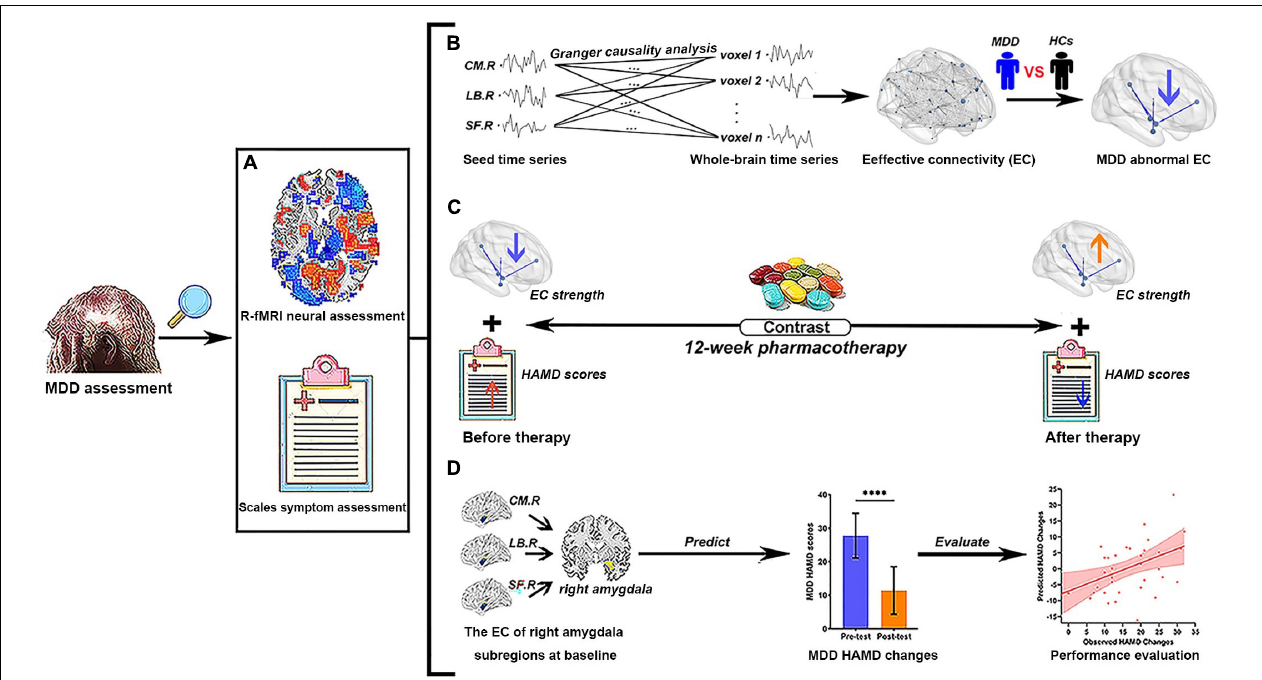
FIGURE 1 | Study flowchart of current research. (A) Two different MDD assessment methods were used in the present study. (B) The EC analysis of right amygdala subregions using Granger causality analysis. We explore abnormal right amygdala subregion-based EC in MDD patients by the comparison of R-fMRI data between MDD and HCs. (C) The contrast of the variance of EC strength and the changes of HAMD scores of MDD patients before and after pharmacotherapy, respectively. (D) The voxel-wise EC strength of right amygdala subregions at baseline is taken as feature sets to predict the changes of HAMD scores in MDD patients. The Spearman’s rank correlation between predicted HAMD scores changes and observed HAMD scores changes is used to evaluate the prediction power of current predictors. MDD, major depressive disorder; HC, healthy controls; R-fMRI, resting-state functional magnetic resonance imaging; CM, centromedial amygdala; LB, basolateral amygdala; SF, superficial amygdala; EC, effective connectivity; HAMD, 24-item Hamilton Rating Scale for Depression; L, left hemisphere; R, right hemisphere. Different color arrows indicate the change direction of studied indicators compared with the previous stage: cool colors indicate decrease and warm colors indicate increase. **** p <